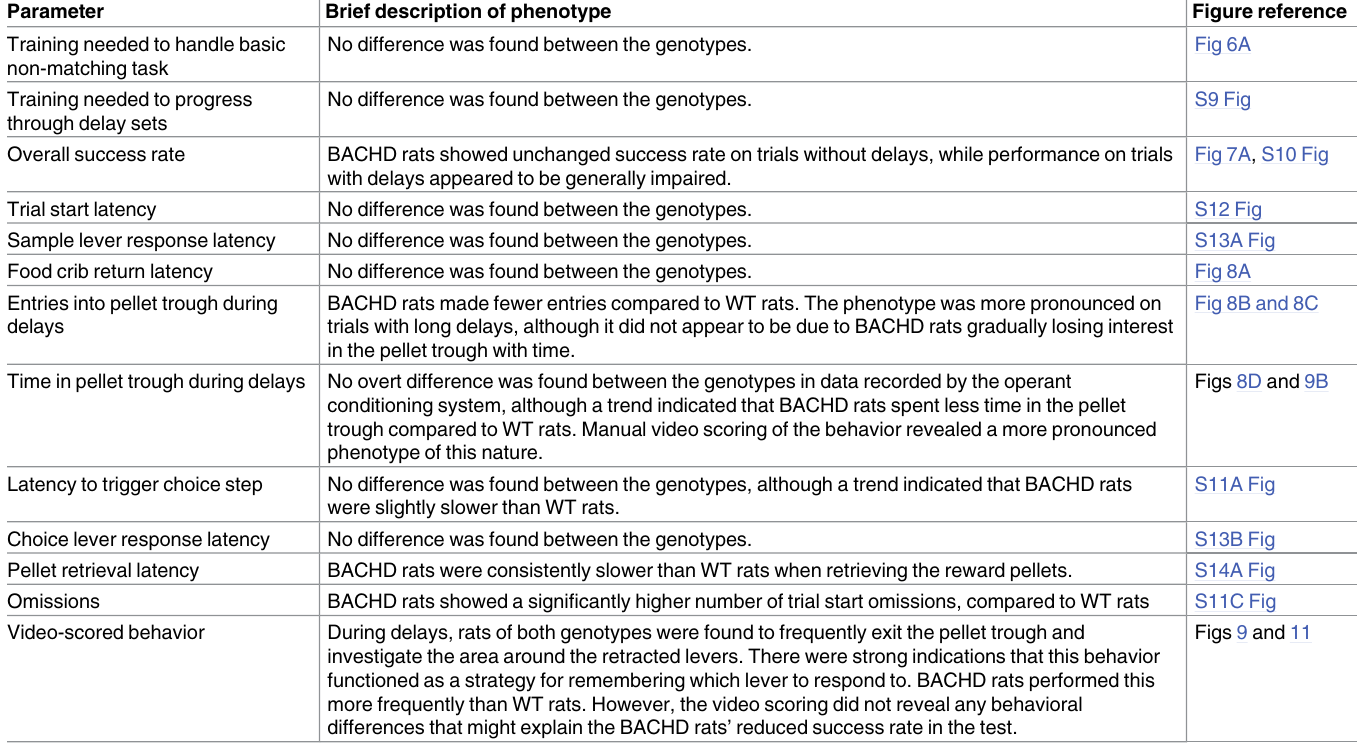
Table 2. Overview of results from the delayed non-matching